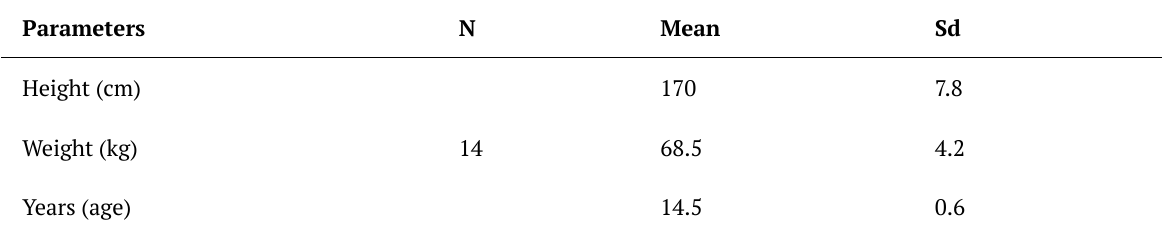
Table 1. Descriptive statistics of the participants